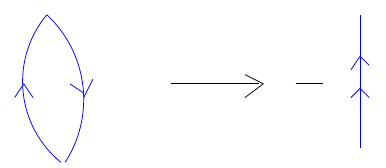
Figure 4 . A pattern for the boundary